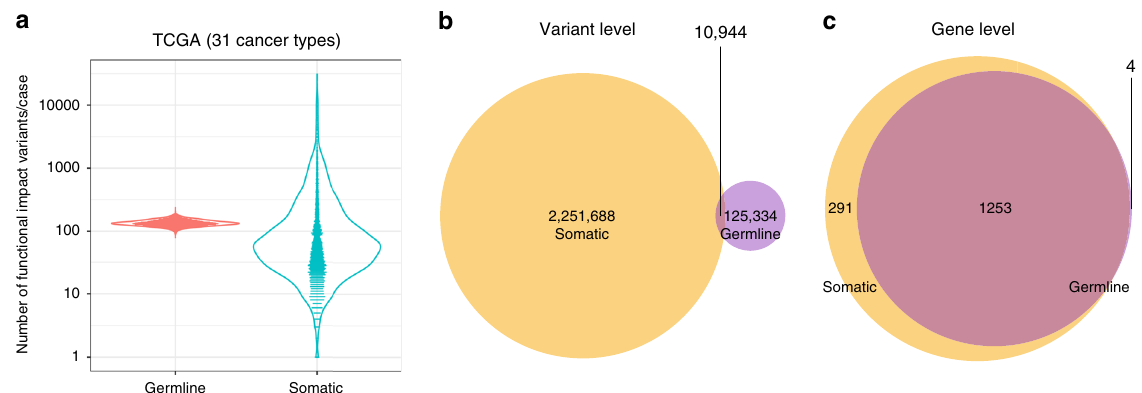
Fig. 1 Distribution of gHFI variants and somatic mutations in protein-coding genes in the TCGA. a The number of high-functional impact germline variants and somatic mutations from 7468 patients with 31 different cancer types. b Venn diagram of loci affected by germline variants and somatic mutations. c Venn diagram of cancer hallmark genes ( n = 1558) affected by germline variants and somatic mutations in the